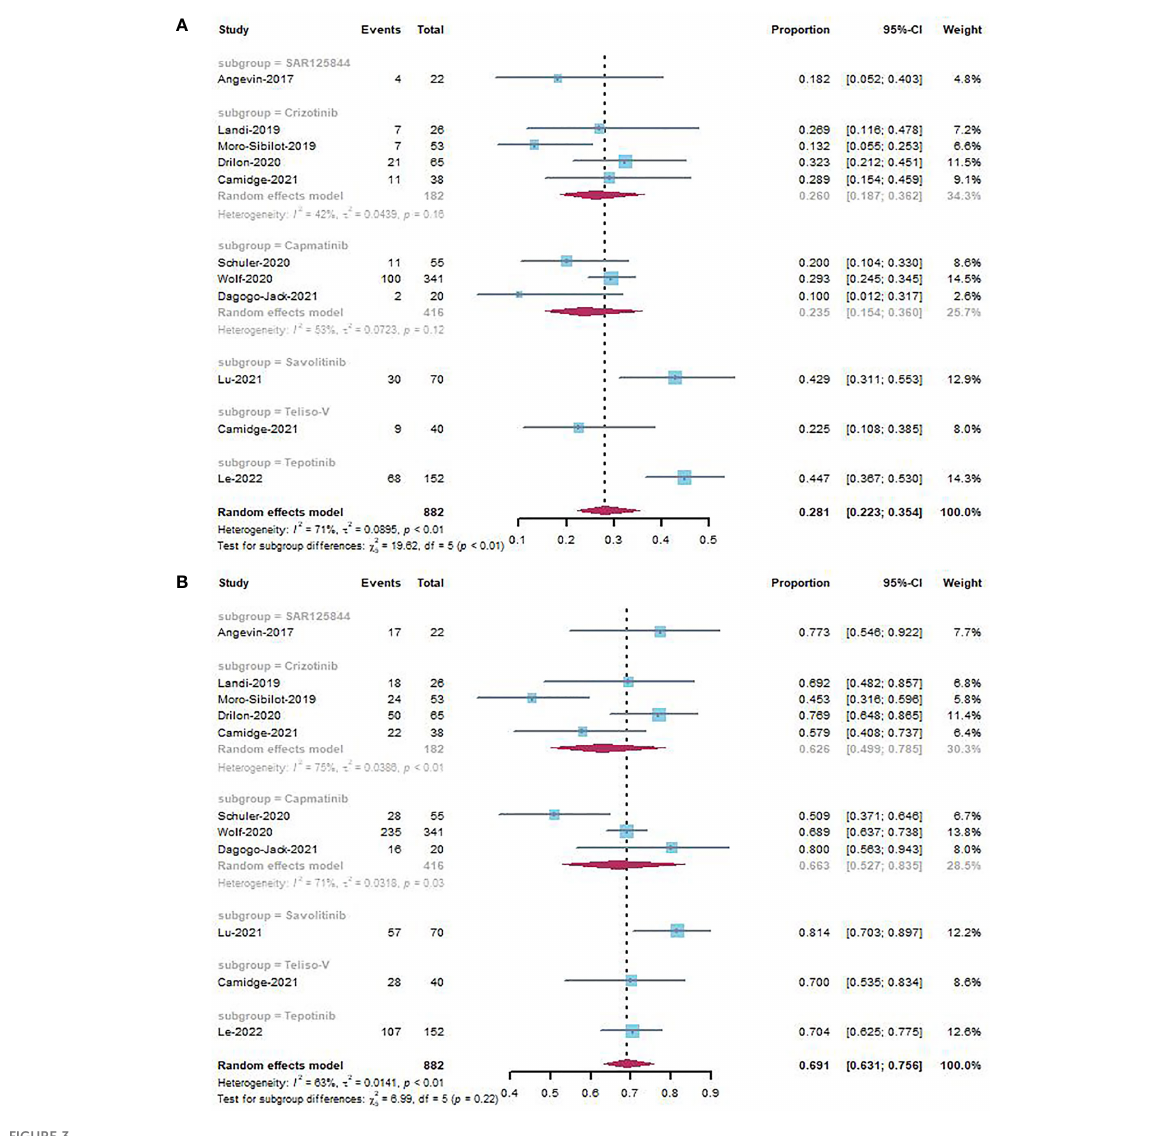
FIGURE 3 Subgroup analyses by different MET inhibitors of ORR (A) and DCR (B) in NSCLC